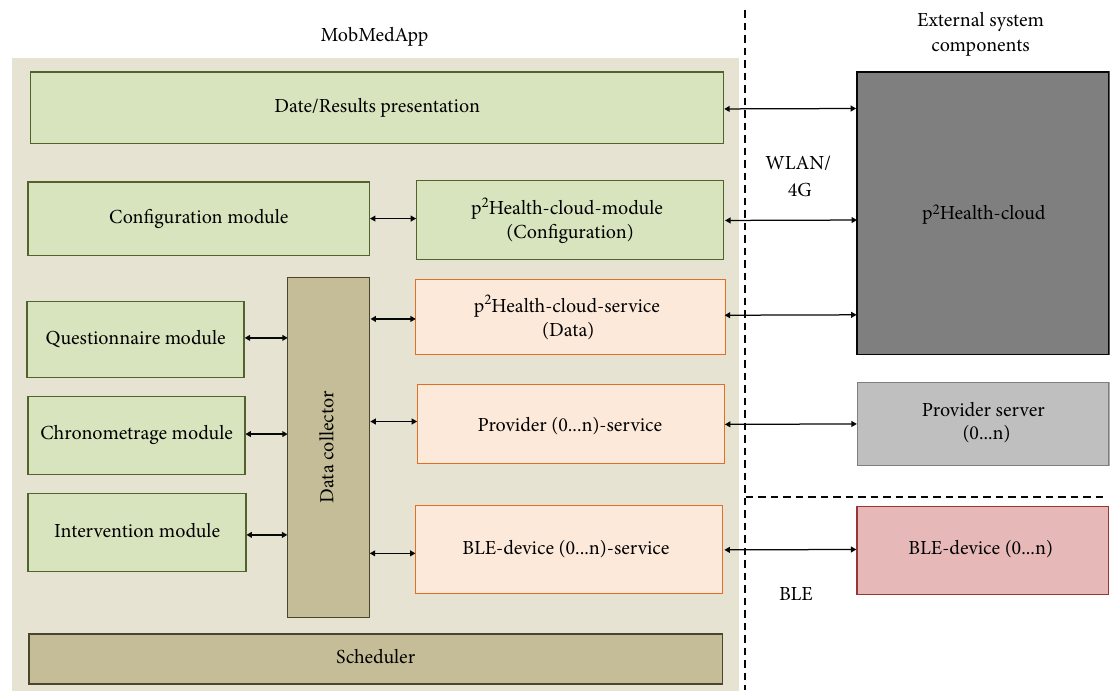
Figure 5: Architecture of the MobM edApp